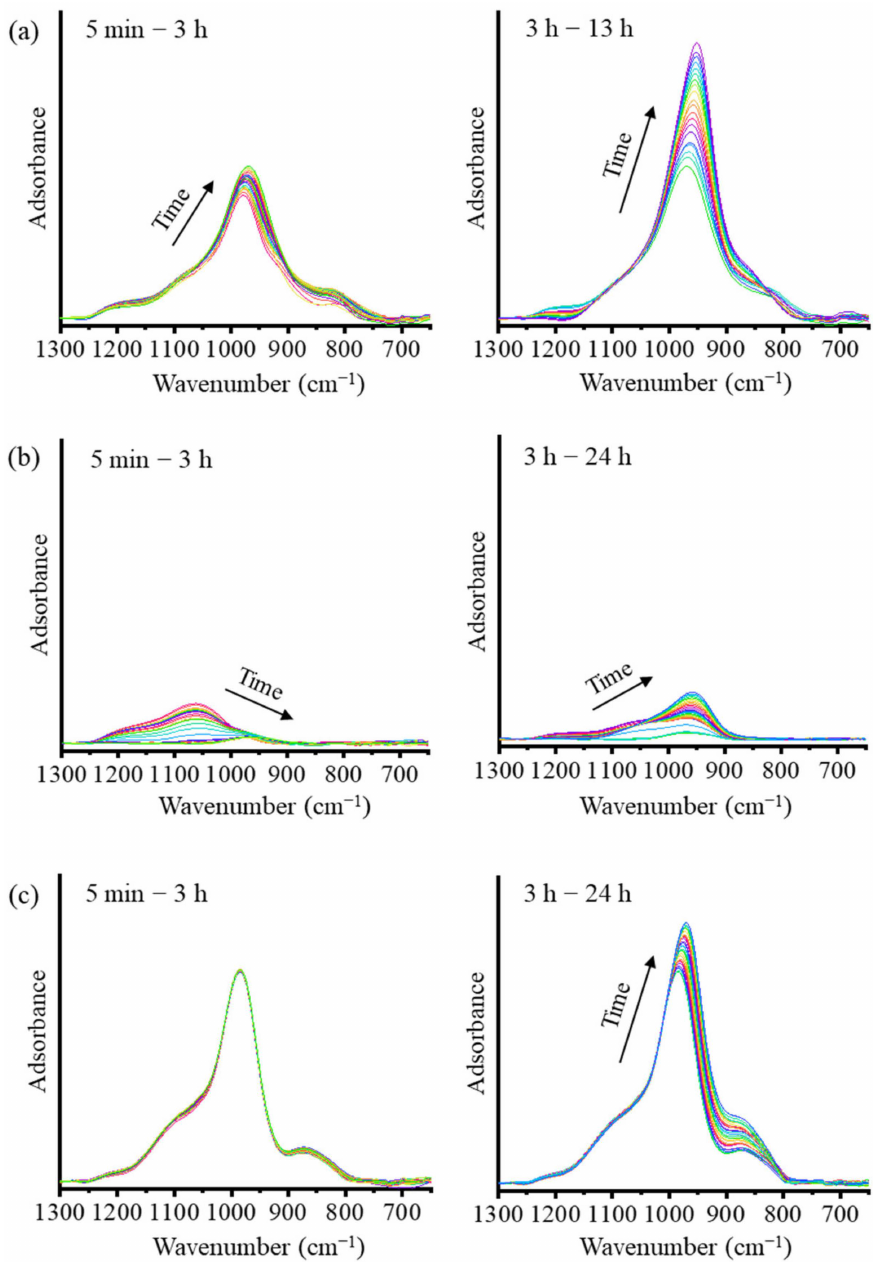
Figure 3. ATR-FTIR spectra of ( a ) the mixed solution-based AAM, ( b ) the NaOH solution-based AAM, and ( c ) the Na 2 SiO 3 solution-based AAM, at different time points. The three-dimensional waterfall ATR-FTIR spectra of the mixed solution-based, NaOH solution-based, and Na 2 SiO 3 solution-based AAM pastes are presented in Figure 1. The spectra show the changes that occurred in the overall and main peak intensities due to the polymerization reaction of the AAM paste that occurred over a period of 24 h. As can be seen in Figure 1a, the peak slightly shifts to a lower wavenumber and increases in height with the increase in the reaction time. The height of the peak shoulder at approximately 800 cm − 1 has slightly decreased. Figure 1b shows that the height of the peak of the NaOH solution-based paste at 1100 cm − 1 decreases until 3 h, after which it starts to increase again. The heights of the peak and the peak shoulder of the Na 2 SiO 3 solution-based AAM paste at 1000 cm − 1 and 850 cm − 1 , respectively, increase with the increasing reaction time (Figure